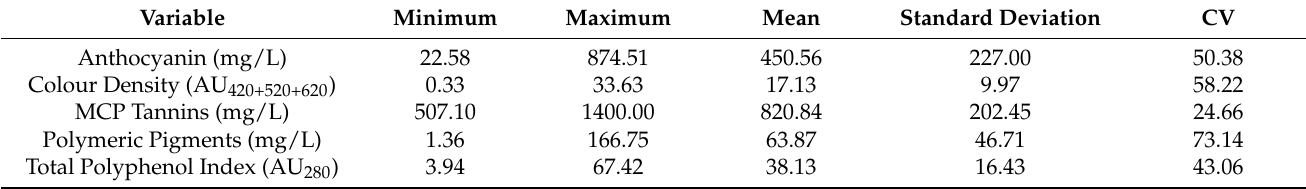
Table 1. Summary Statistics of Phenolic Parameters for Must and